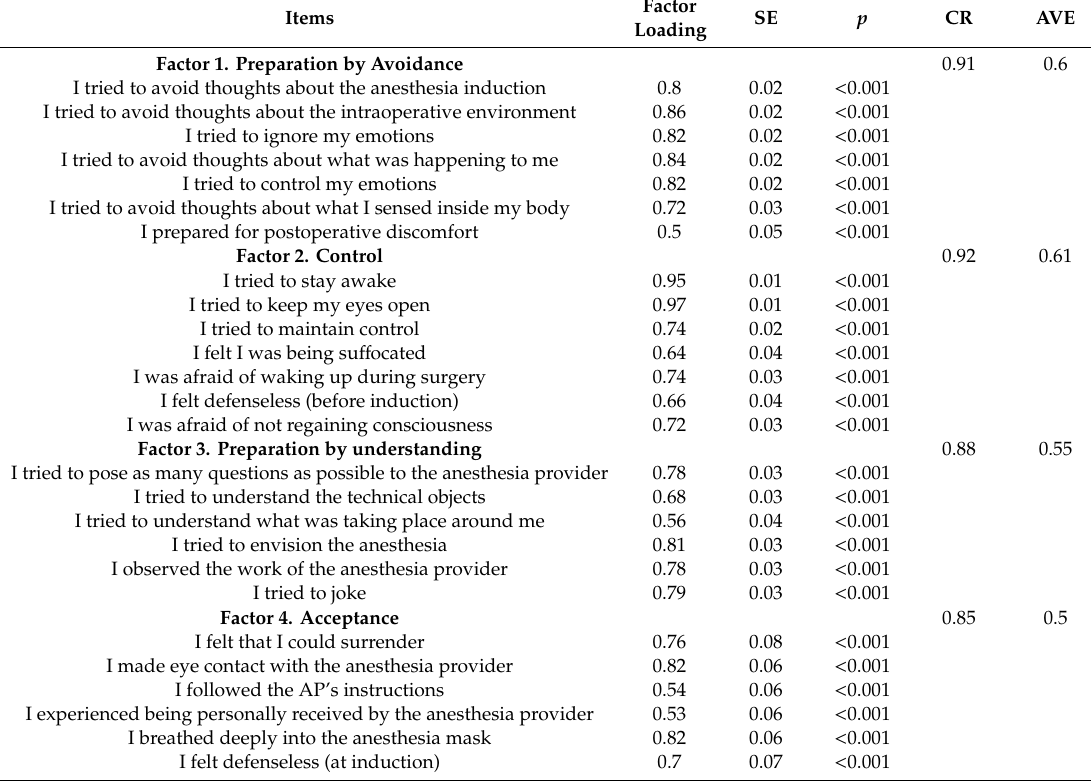
Table 3. Confirmatory factor analysis of anesthesia surrendering instrument (N = 306).